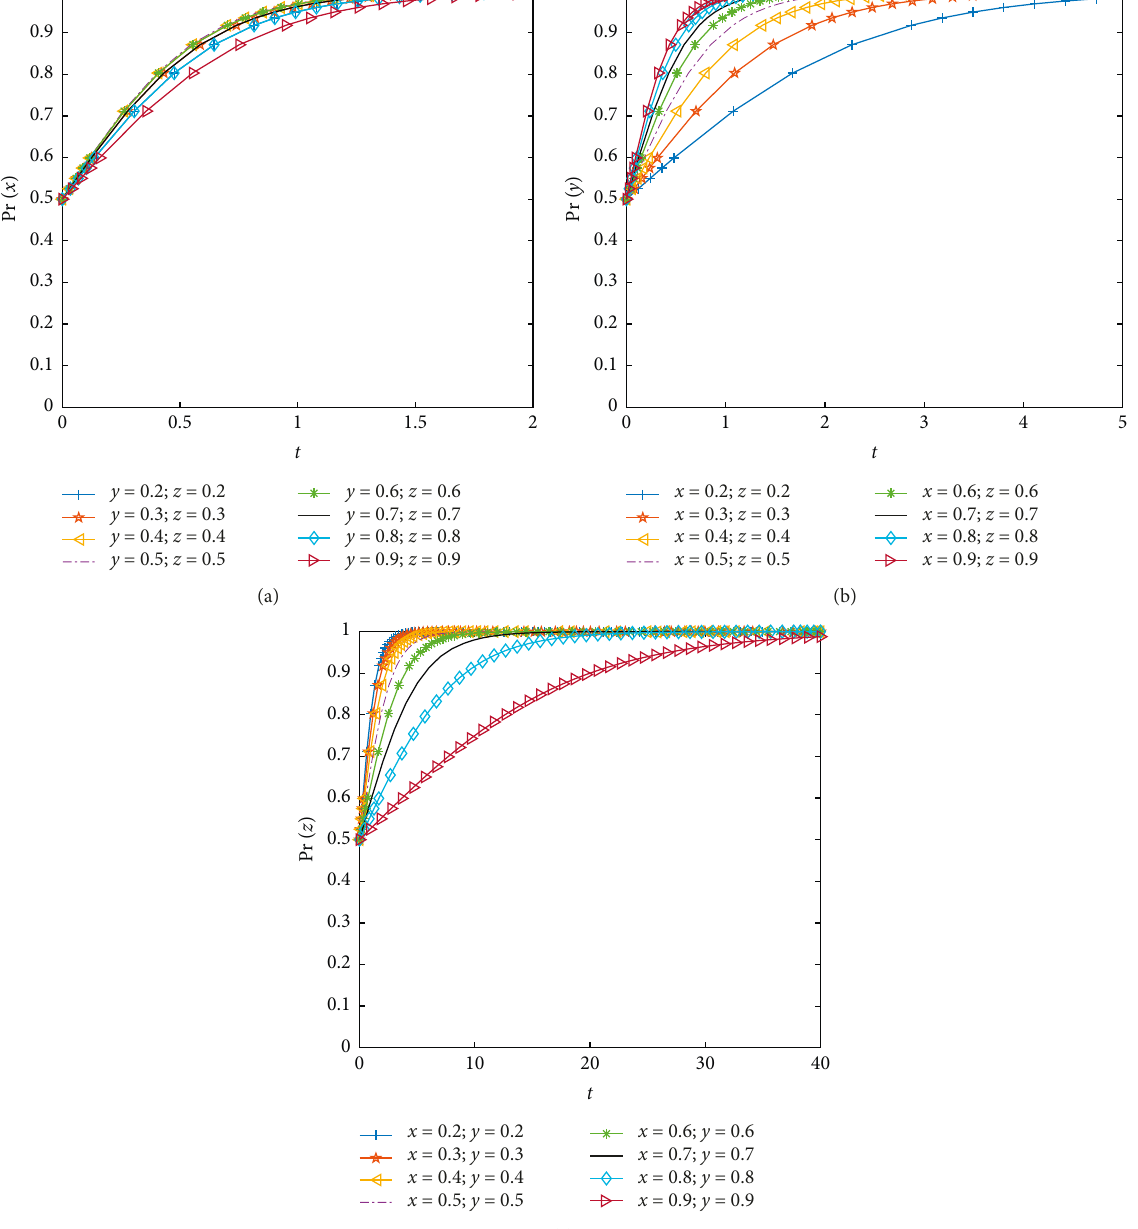
are unchanged; the evolution result of the dynamic game system is shown in Figure 8.